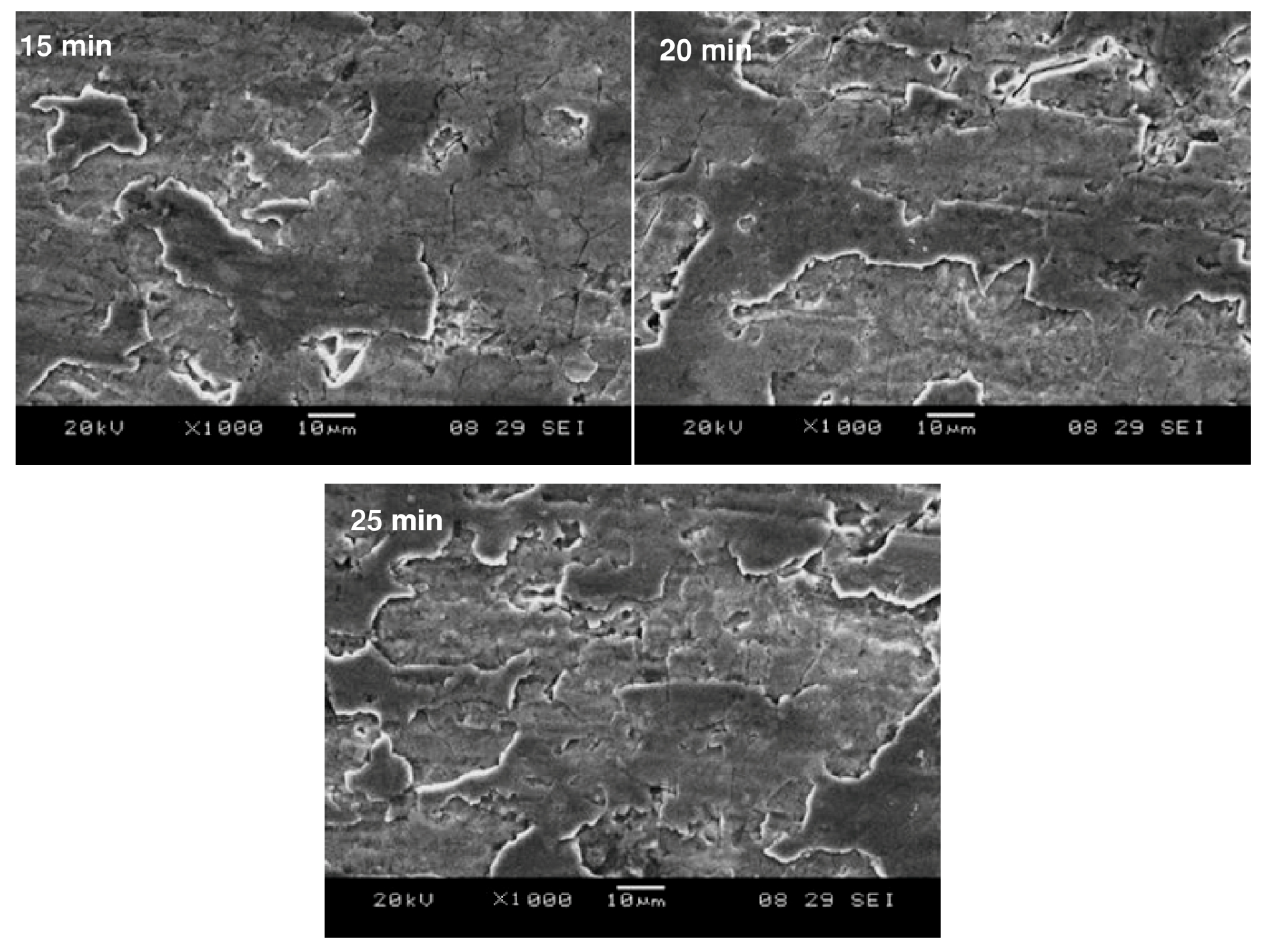
Figure 2. Surface topography of the SMAT modified samples treated for 15 min, 20 min and 25 min.